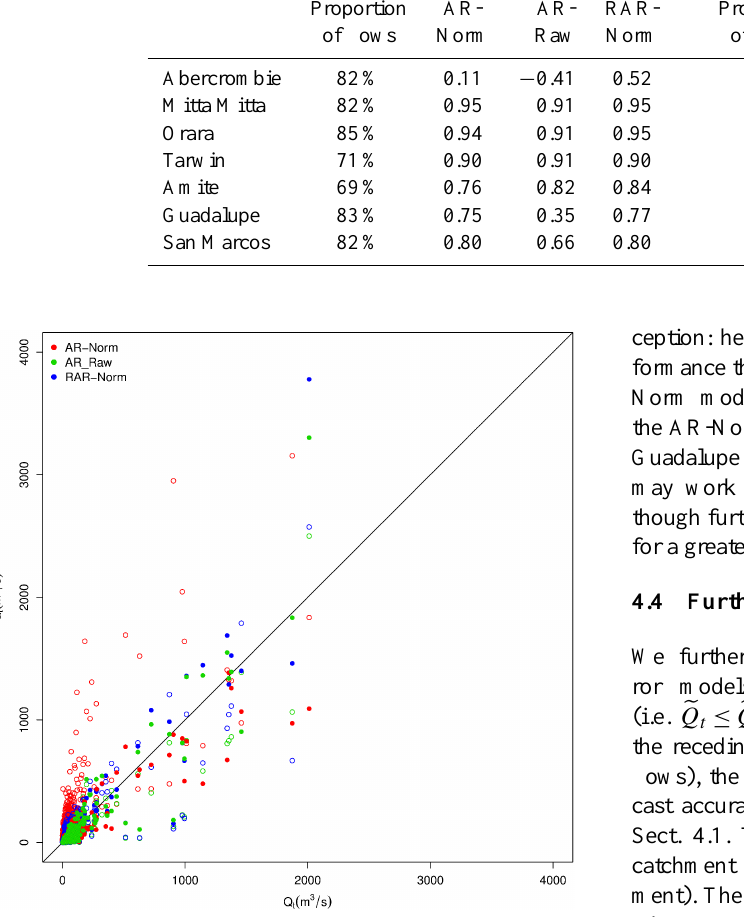
Figure 8. Comparison of the observed streamflows ( Q t ) and fore- cast streamflows ( e Q t ), as forecast: (1) with the base hydrological model (circles); and (2) with the base hydrological model and error updating models (dots) for the Orara